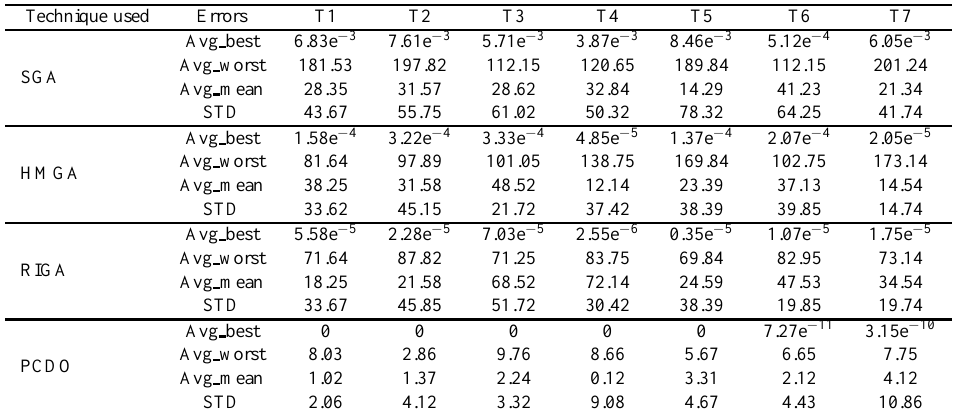
Table 5. Error Values Achieved for Problems F 5